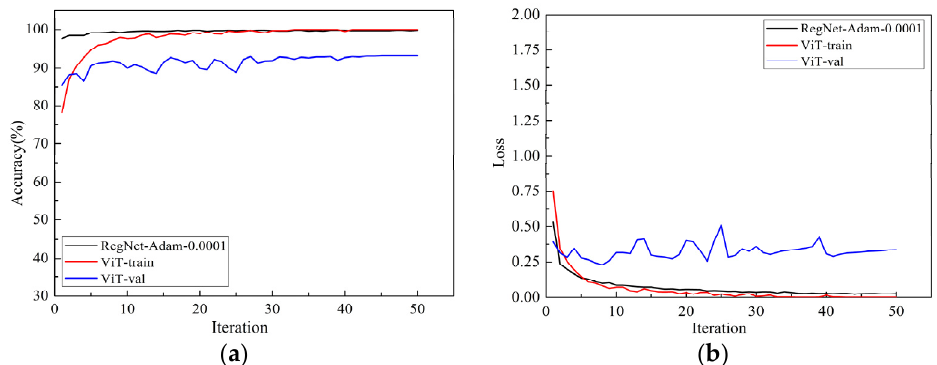
Figure 8. The performance of the two models: ( a ) the accuracy curve of the models; ( b ) the loss curve of the models.